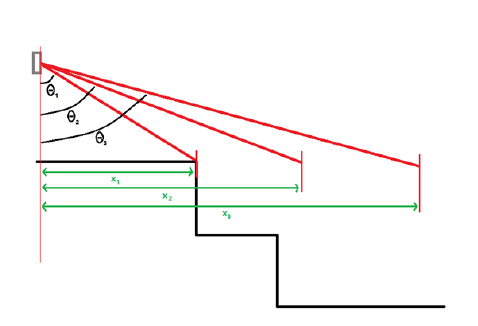
Figure 8. Pothole and Drains Modelling